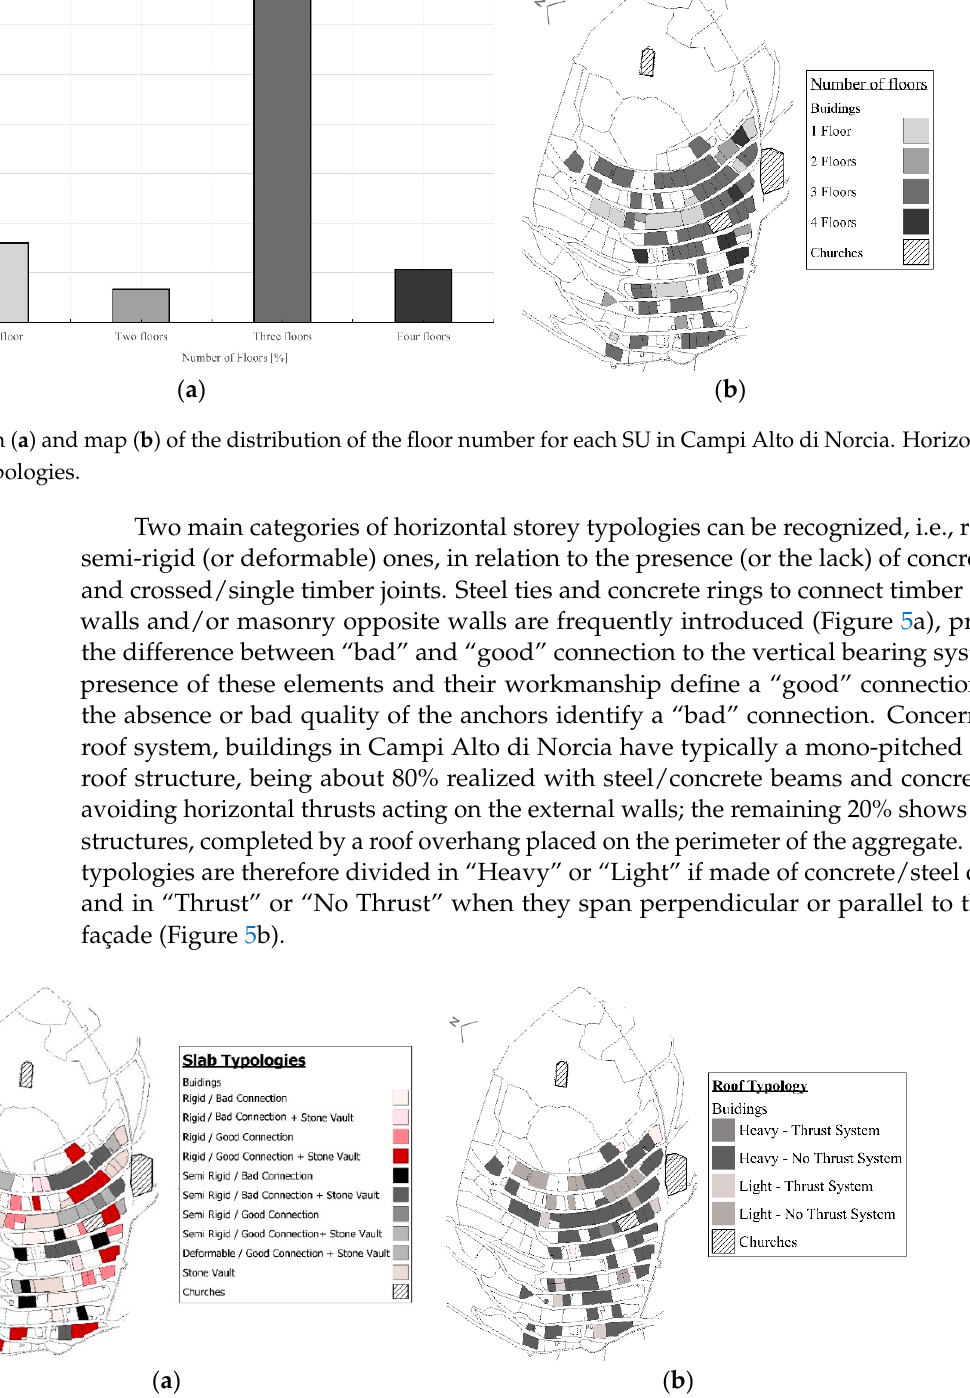
Figure 5. ( a ) Distribution of floor’s typology; ( b ) distribution of the roof typology.